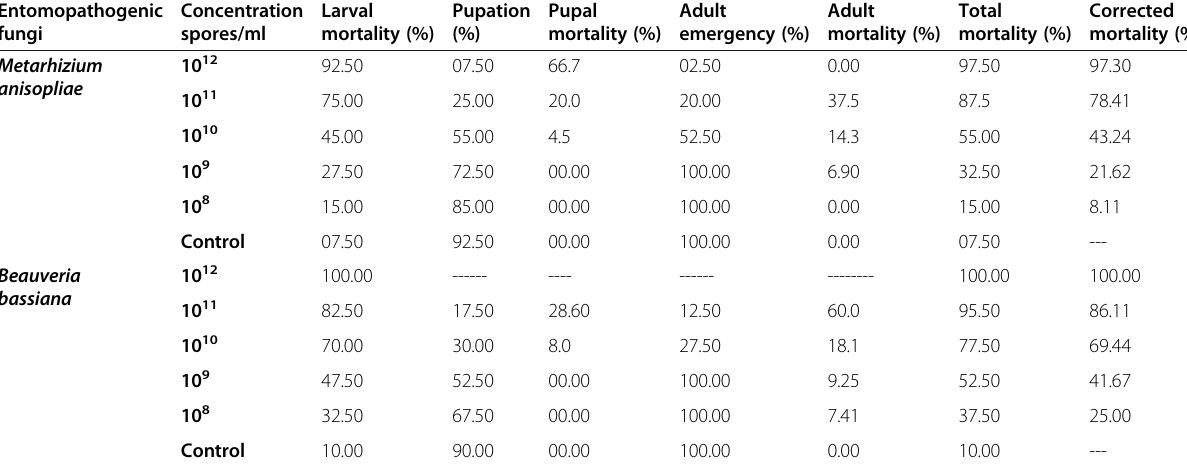
Table 2 Effect of the fungal isolates against the newly hatched larvae (neonate) of Pectinophora gossypiella Entomopathogenic Concentration fungi spores/ml